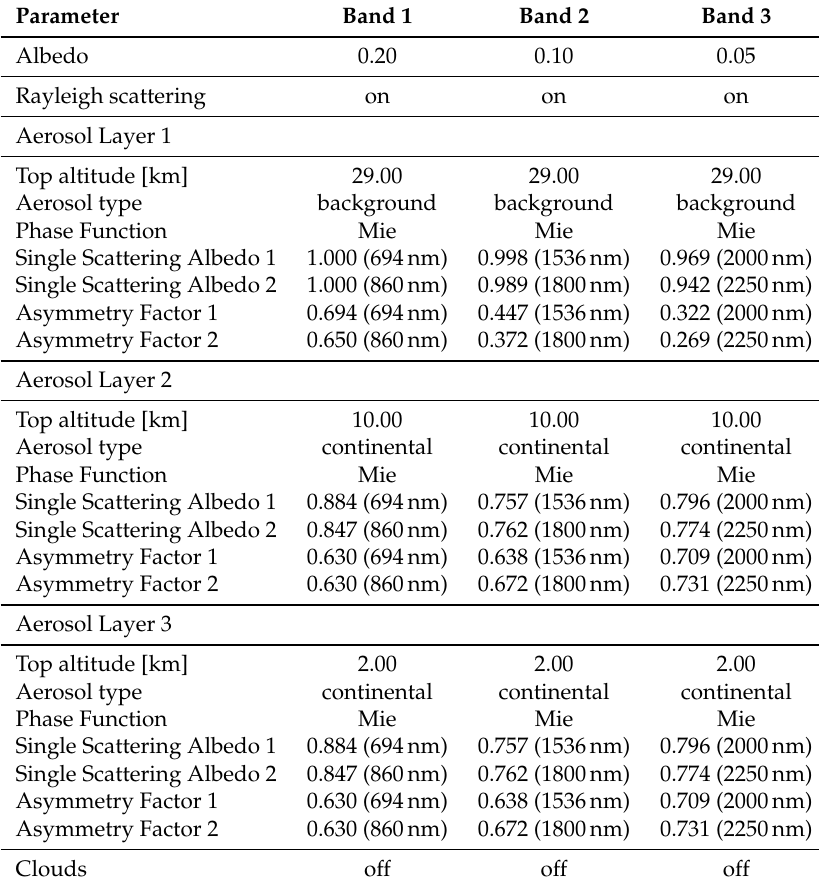
Table A9. Scattering parameters of scenario Rayleigh+Aerosol cont. .